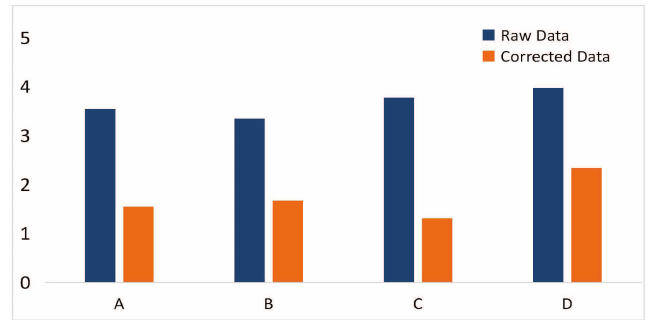
Figure 8. The standard deviation of the RSSI before and after correction.